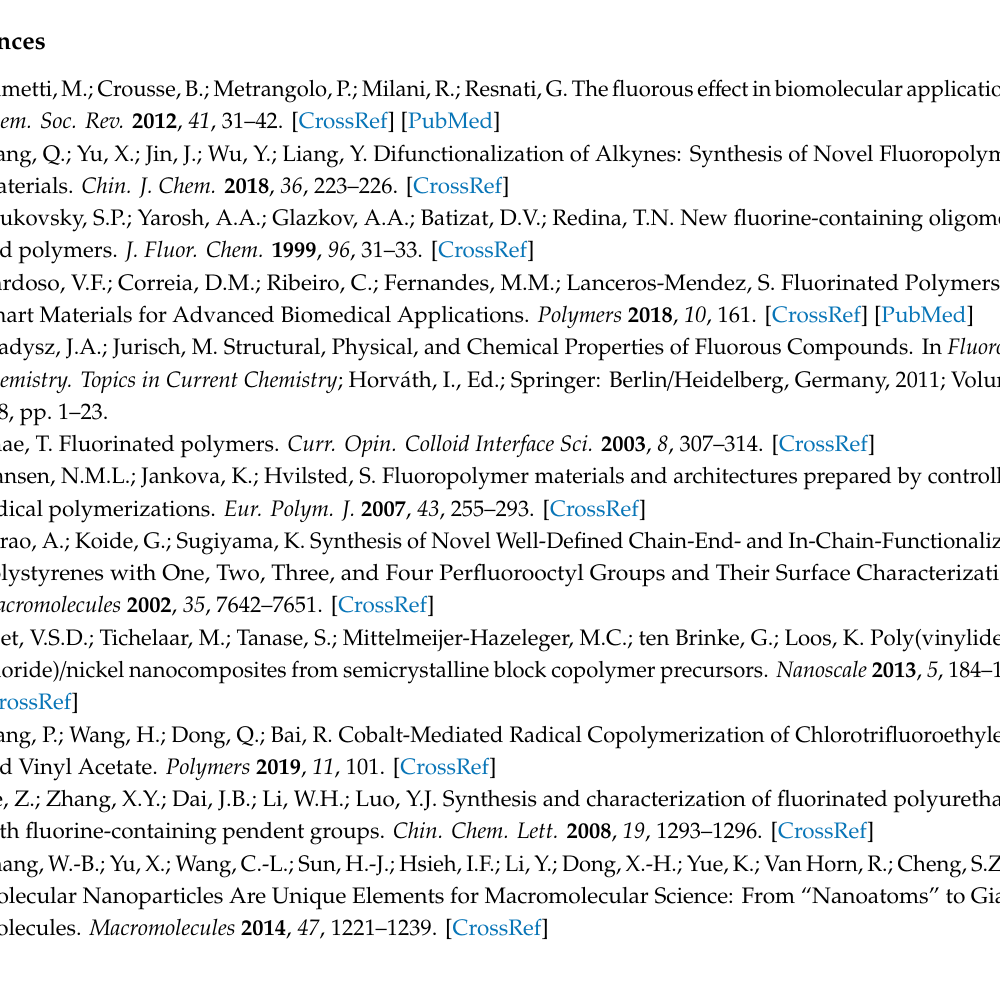
Figure S1: GPC curves of PS macroinitiators., Figure S2: Representative 1H NMR spectrum of S-b-F block polymer, Figure S3: Representative GPC overlay of PS-initiator and S-b-F block polymer. Figure S4: Cartoon illustration of the iHEX phase which PS (blue part) forms the column and PFOA (green part) forms the matrix, Table S1: Molecular weight and distribution of PS